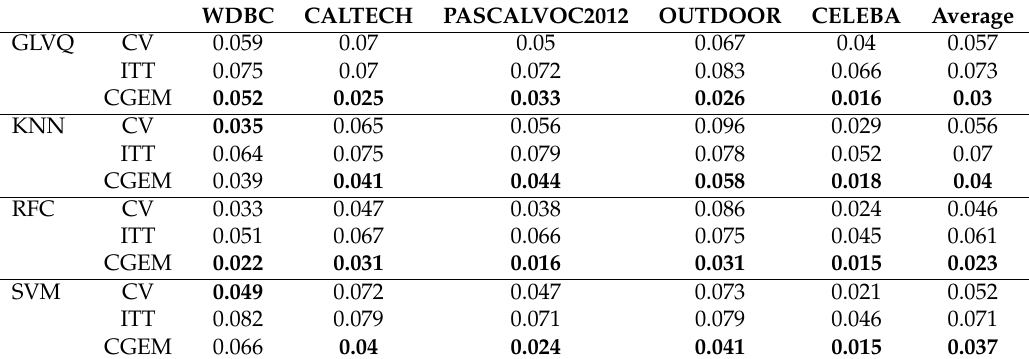
Table 4. Evaluation of accuracy estimation error (AEE) of CGEM approach compared to baseline models. The classifier was trained incrementally with random sampling. Accuracy estimation was done after each batch. The table shows mean absolute error (MAE) compared to ground truth.